Question: Express in one sentence what the figure is showing.
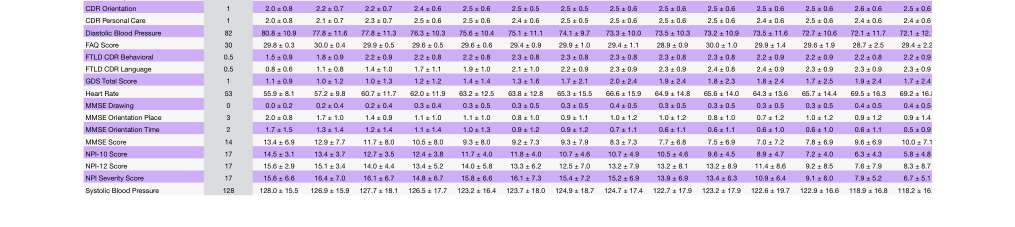
Answer: An example twin record for a single FTD patient is shown, which reports the mean and standard deviation of the twins for that patient. A sample of static baseline information is given at the top of the record. A sample of longitudinal outcomes predicted by the model are supplied as rows, with columns indicating the time in months since baseline visit.